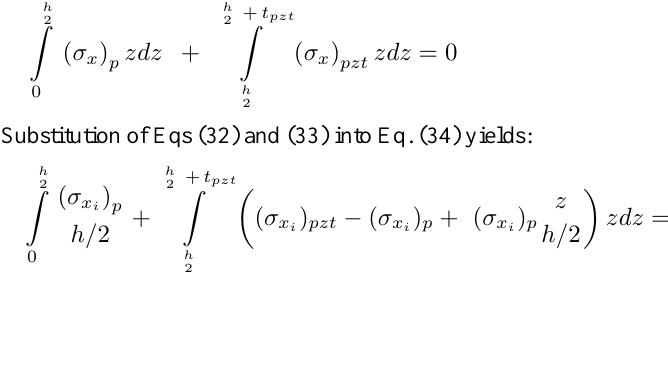
Fig. 15. Continuous Sensor response due to a lead break (simulation scaled – dashed, test – solid